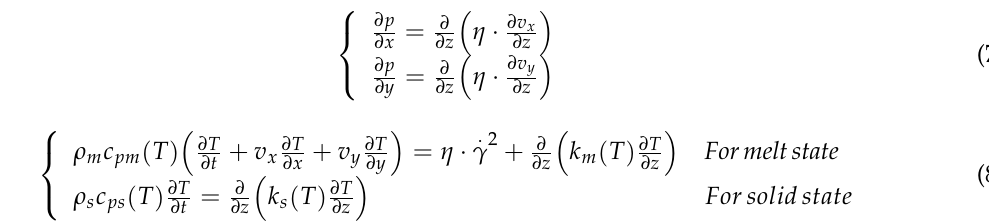
Table 1. Viscosity models for describing the non-Newtonian behavior of plastic melt [21–23]. Model Contributor . − 1 De Waele (1923) and Ostward (1925) η = K · γ n Ferry (1942) Cross (1965,1968) Willianms, Landel and Ferry (1955) Yasuda, Armstrong and Cohen